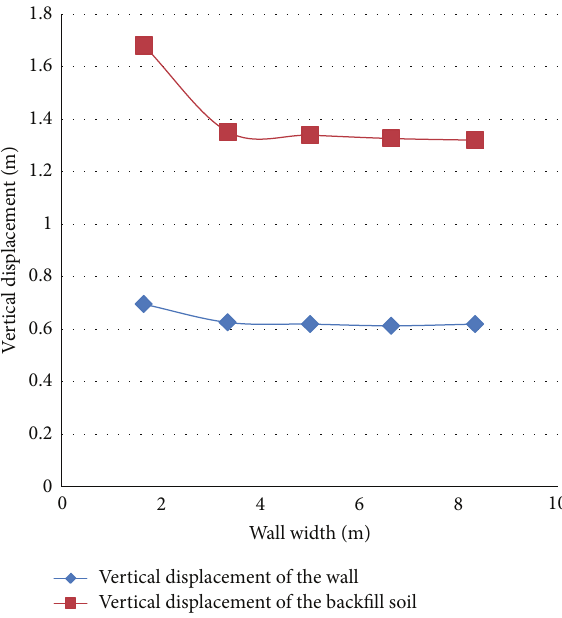
Figure 7: Vertical displacement of the wall and the